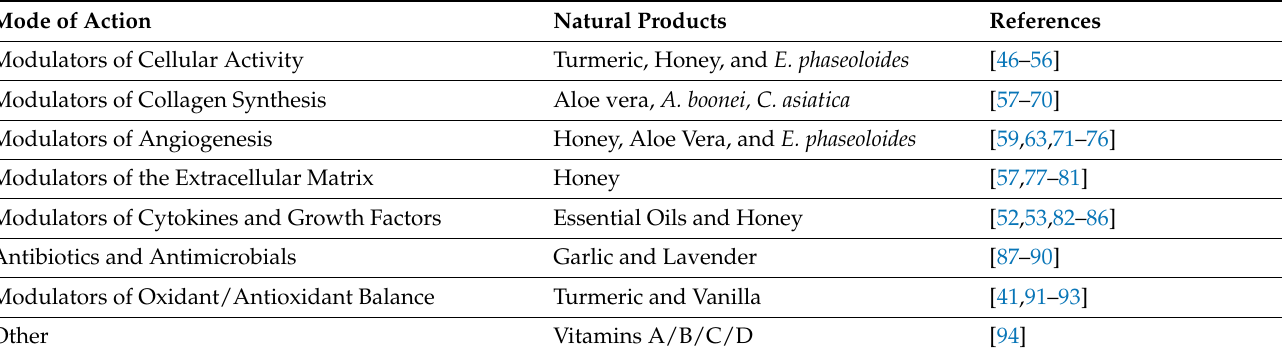
Table 2. Wound healing natural products are classified into their mechanism of